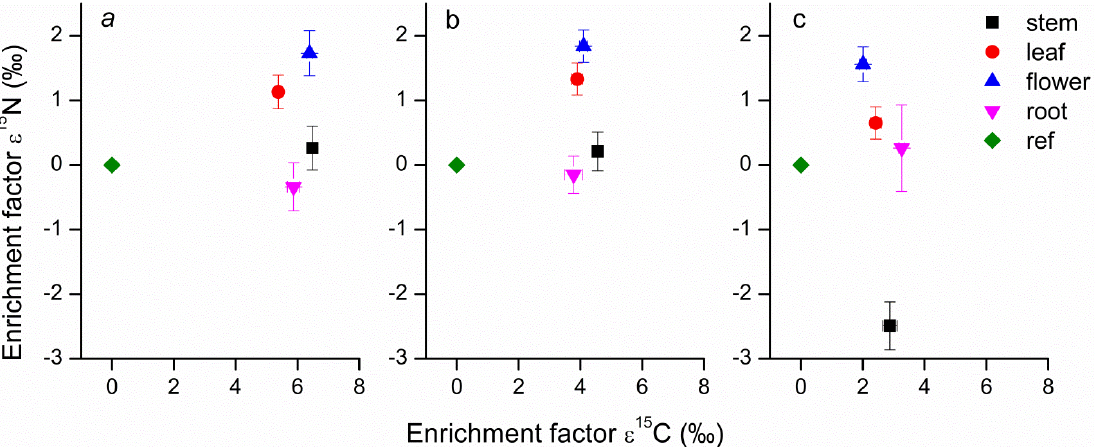
Figure 7. Mean enrichment factors (ε) for 13 C and 15 N of stem, leaf, flower, and root tissues of three Bletilla species, and leaf tissue of autotrophic reference plants (ref). For the reference plants, mean ε is zero by definition. ( a ) represents B. striata ; ( b ) represents B. ochracea ; ( c ) represents B. formosana . Error bars represent standard errors of the mean enrichment factors for 13 C or 15 N (n = 5).